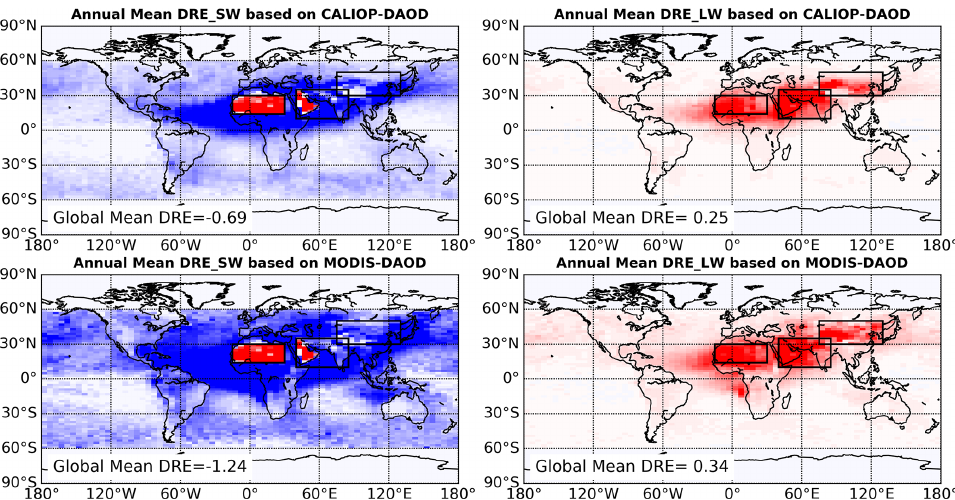
Figure 10. Annual mean dust DRE global distributions based on CALIOP and MODIS DAOD climatology. The MeanSWRI-MeanLWRI- Spheroid dust model is used to represent dust RI and shape in the calculations. Campaign PSD is used to represent dust PSD, specifically, Fennec-Fresh PSD is used to represent dust PSD over the three major dust source regions indicated by three black boxes. AER-D PSD is used to represent dust PSD over other regions. Table 4. Globally annual mean DAOD, DRE SW , DRE LW and DRE NET based on CALIOP DAOD and MODIS DAOD climatology. Note, values in parentheses are for the two DAOD scaled to the same value of 0.03. DRE SW DRE LW DRE NET DAOD [Wm − 2 ] [Wm − 2 ] [Wm − 2 ] CALIOP 0 . 032 (0 . 03) − 0 . 69 ( − 0 . 64) 0 . 25 (0 . 23) − 0 . 44 ( − 0 . 41) MODIS 0.047 (0.03) − 1 . 24 ( − 0 . 79) 0 . 34 (0 . 22) − 0 . 90 ( − 0 .